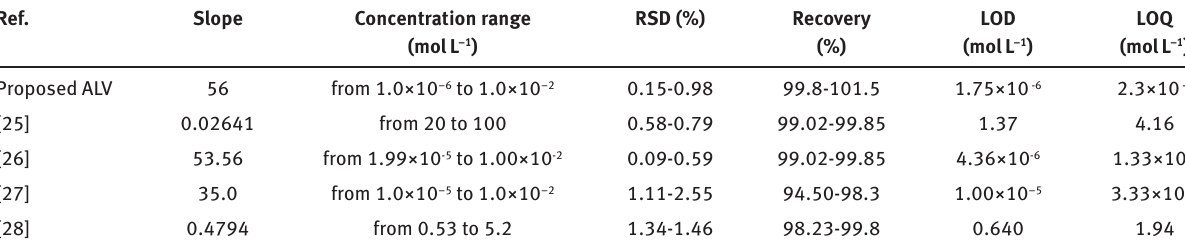
Table 9: Comparison between the proposed sensor and previous methods for ALV Ref.